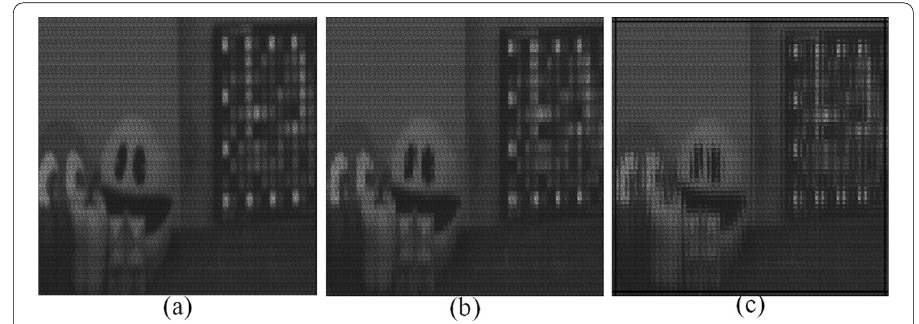
Fig. 6 The compressed light field spectral images of simulations, a z o z o 108 =